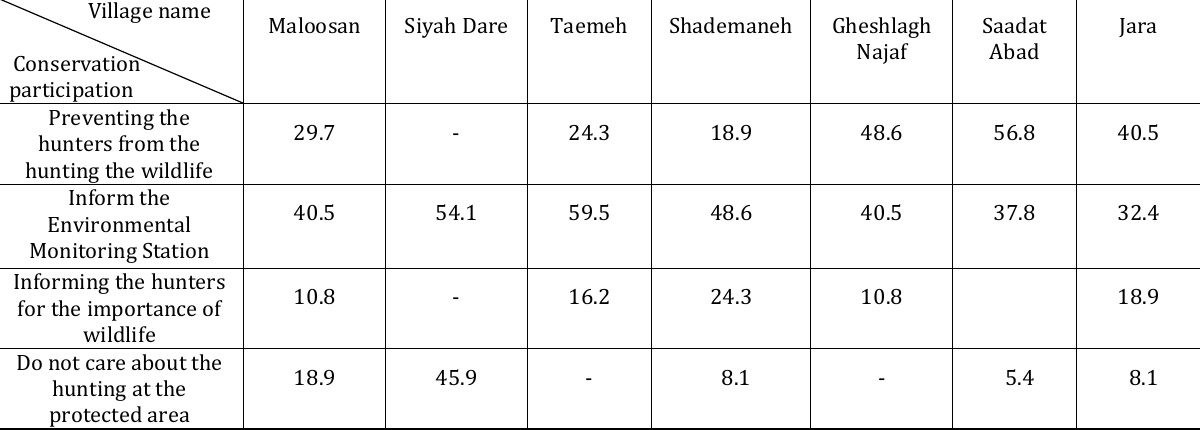
Table 7. Participation in conservation, reaction of local people against hunting of wildlife